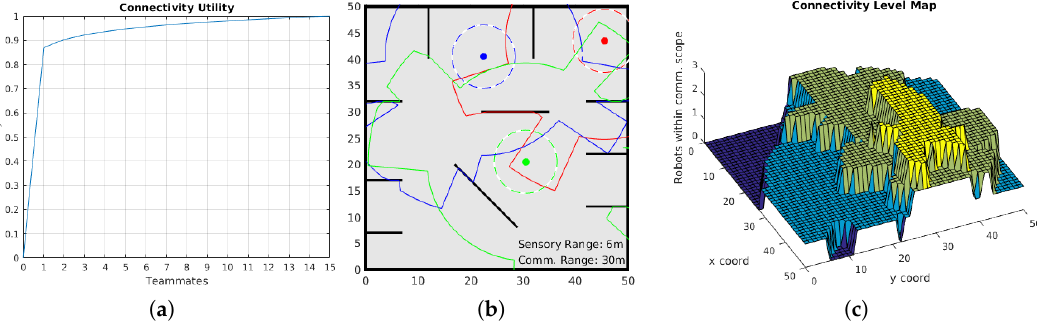
Figure 6. ( a ) Connectivity utility function shape; ( b ) A scene where the usefulness of the Ω function can be appreciated. Three robots (coloured dots) and several walls were arranged simulating an ongoing exploration process. Robots are surrounded with two lines of the same dot colour indicating sensory (dashed) and communication ranges (solid); ( c ) Shows the connectivity level map corresponding to ( b ). Therefore, as long as the will of another robot is to keep connected with the fleet, it would be able to take this perspective into account when deciding where going